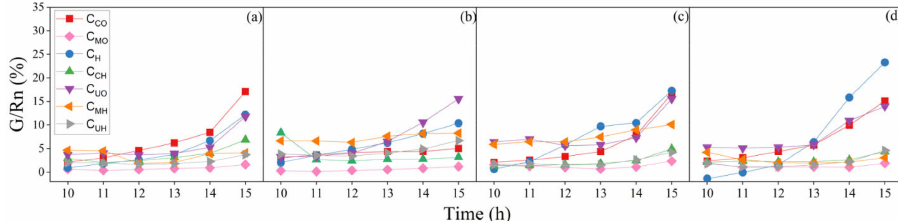
Figure 6. Midday (10–15 h) variations in ratios of soil heat flux to net radiation ( G / Rn ) in seven riparian communities in spring ( a ), summer ( b ), autumn ( c ) and winter ( d